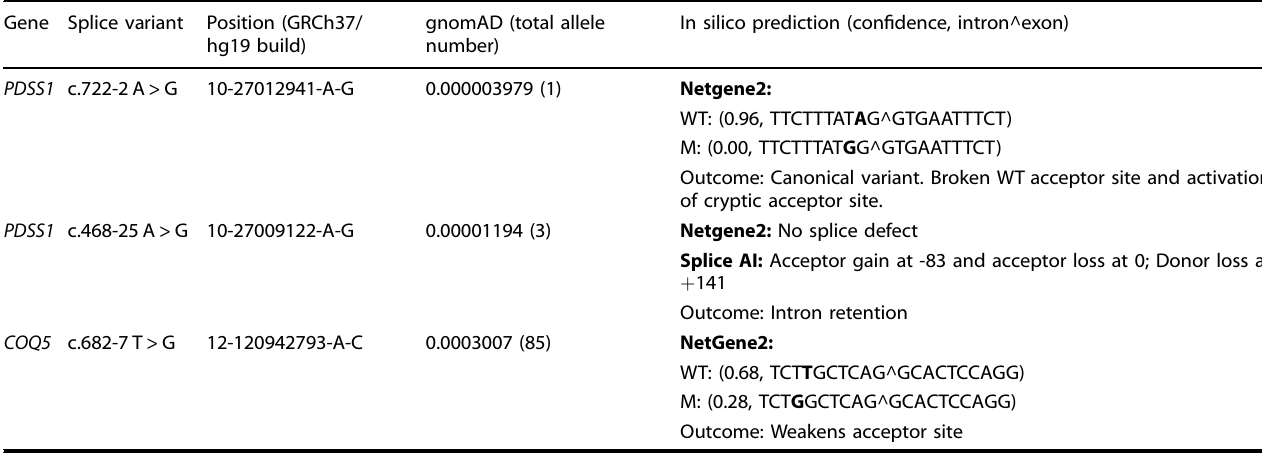
Table 3. In silico prediction on aberrant